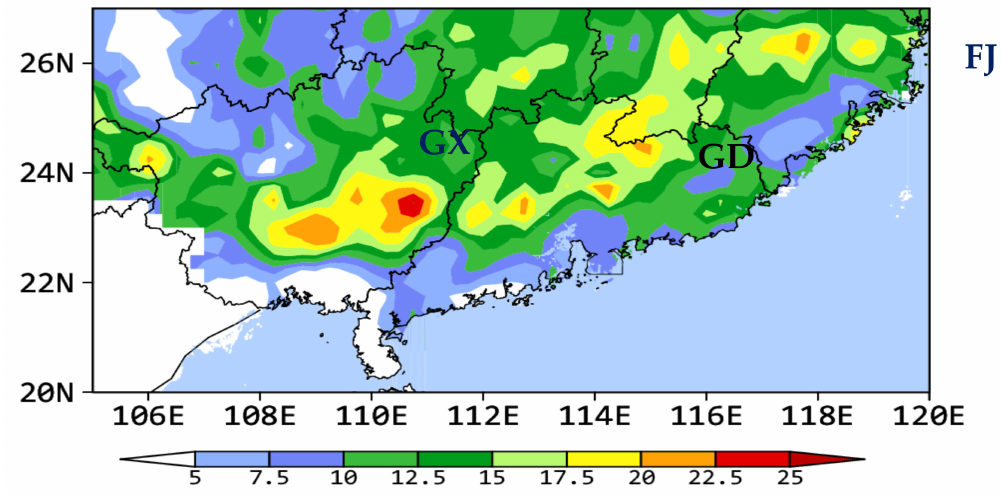
Figure 4. The percentage (%, shadings) of the 21 PSF-type WSHR events with respect to the total WSHR amount during the pre-summer months of